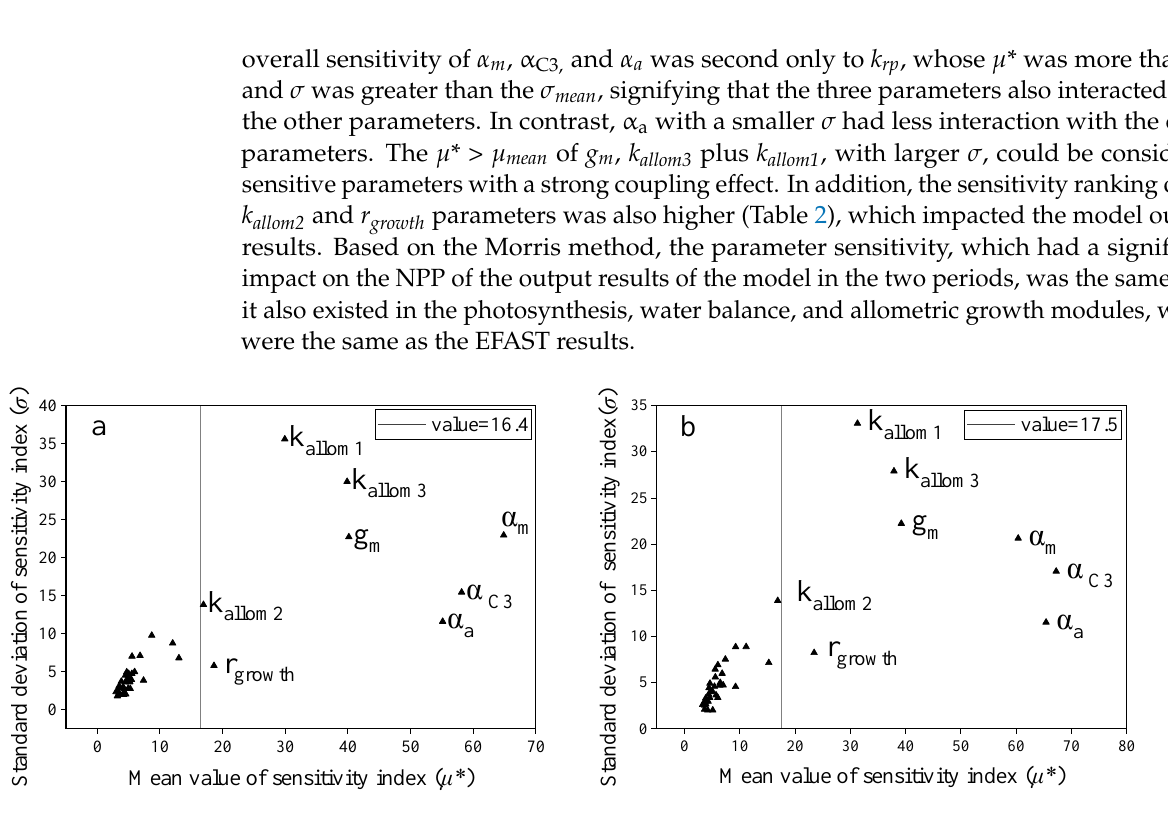
Figure 5. Global sensitivity index( σ and µ *) calculated by the Morris method for NPP simulated by the LPJ model in 2009 – 2014 ( a ) and 2000 – 2019 ( b ).